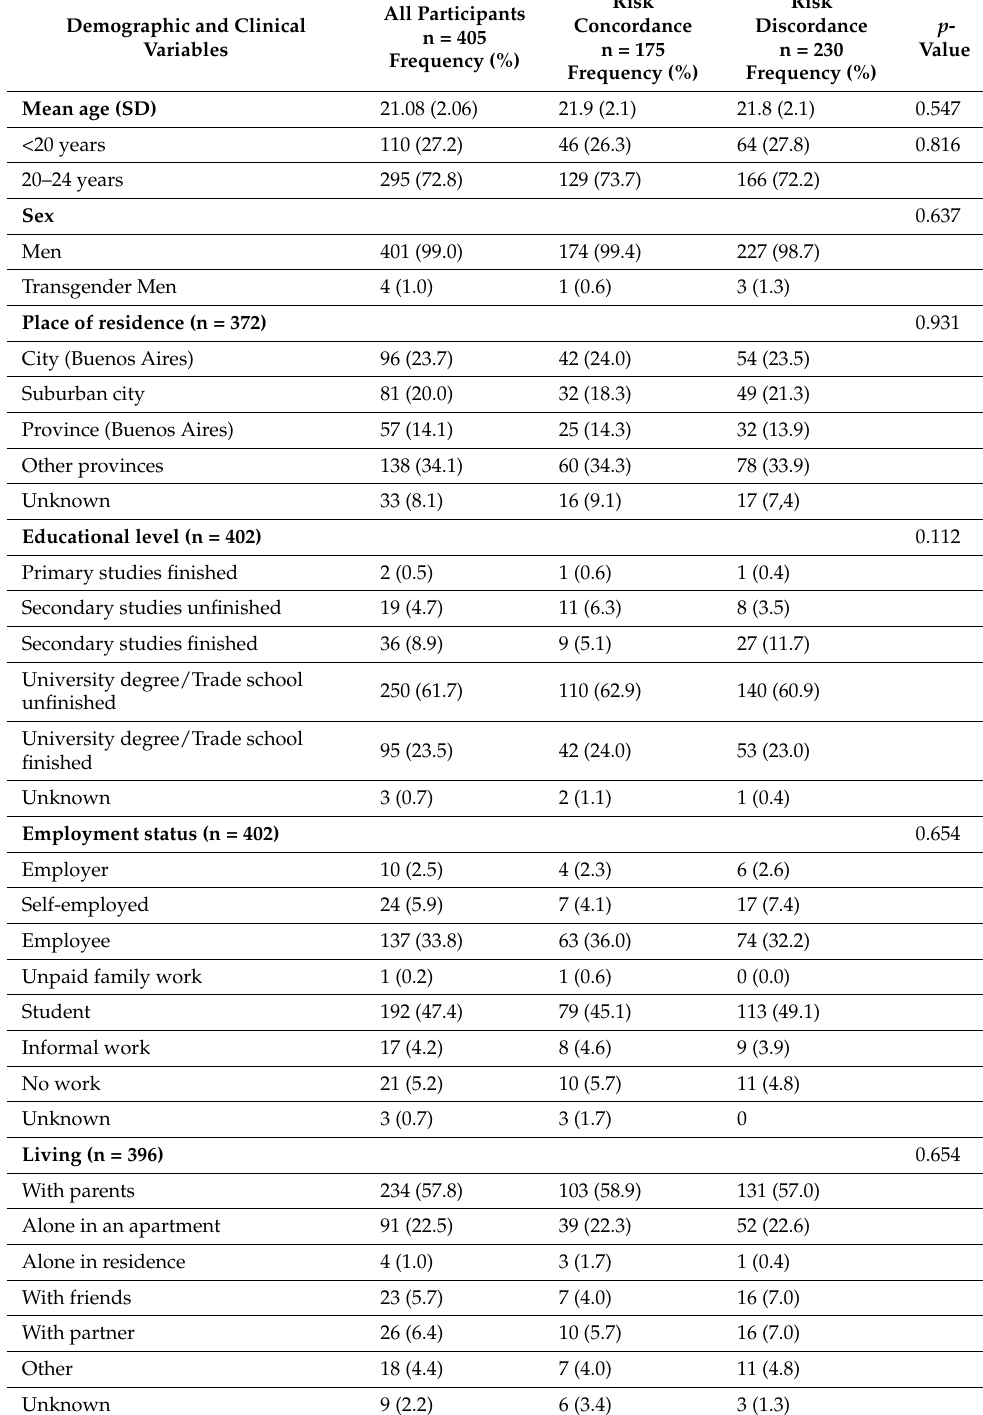
Table 1. Sociodemographic characteristics, internalized homophobia, HIV risk perception (PHRS) and HIV risk (HIRI) based on the absence or presence of HIV risk discordance. p -values from Student’s t-test for continuous variables and chi-squared test for categorical